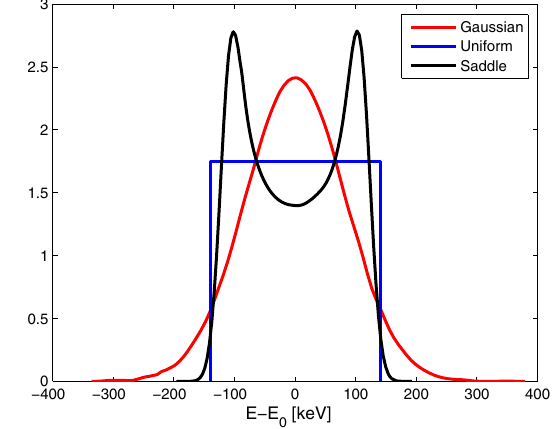
FIG. 1. The different beam energy distributions with rms energy spread of 84 keV for the studies in this